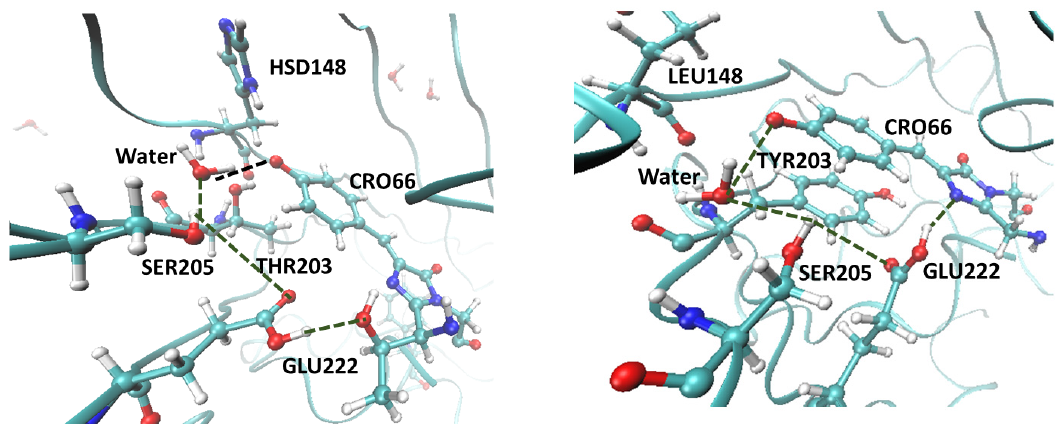
Figure 4. Hydrogen-bond network around the chromophore (CRO) in EGFP (left) and EYFP (right). The network includes CRO:O–water314–SER205–GLU222–CRO:O (Thr65 in EGFP). Glu222 is protonated and His148 is neutral in EGFP (protonated at δ N atom). Also shown is 𝜋 -stacking of the chromophore and Tyr203 in EYFP.